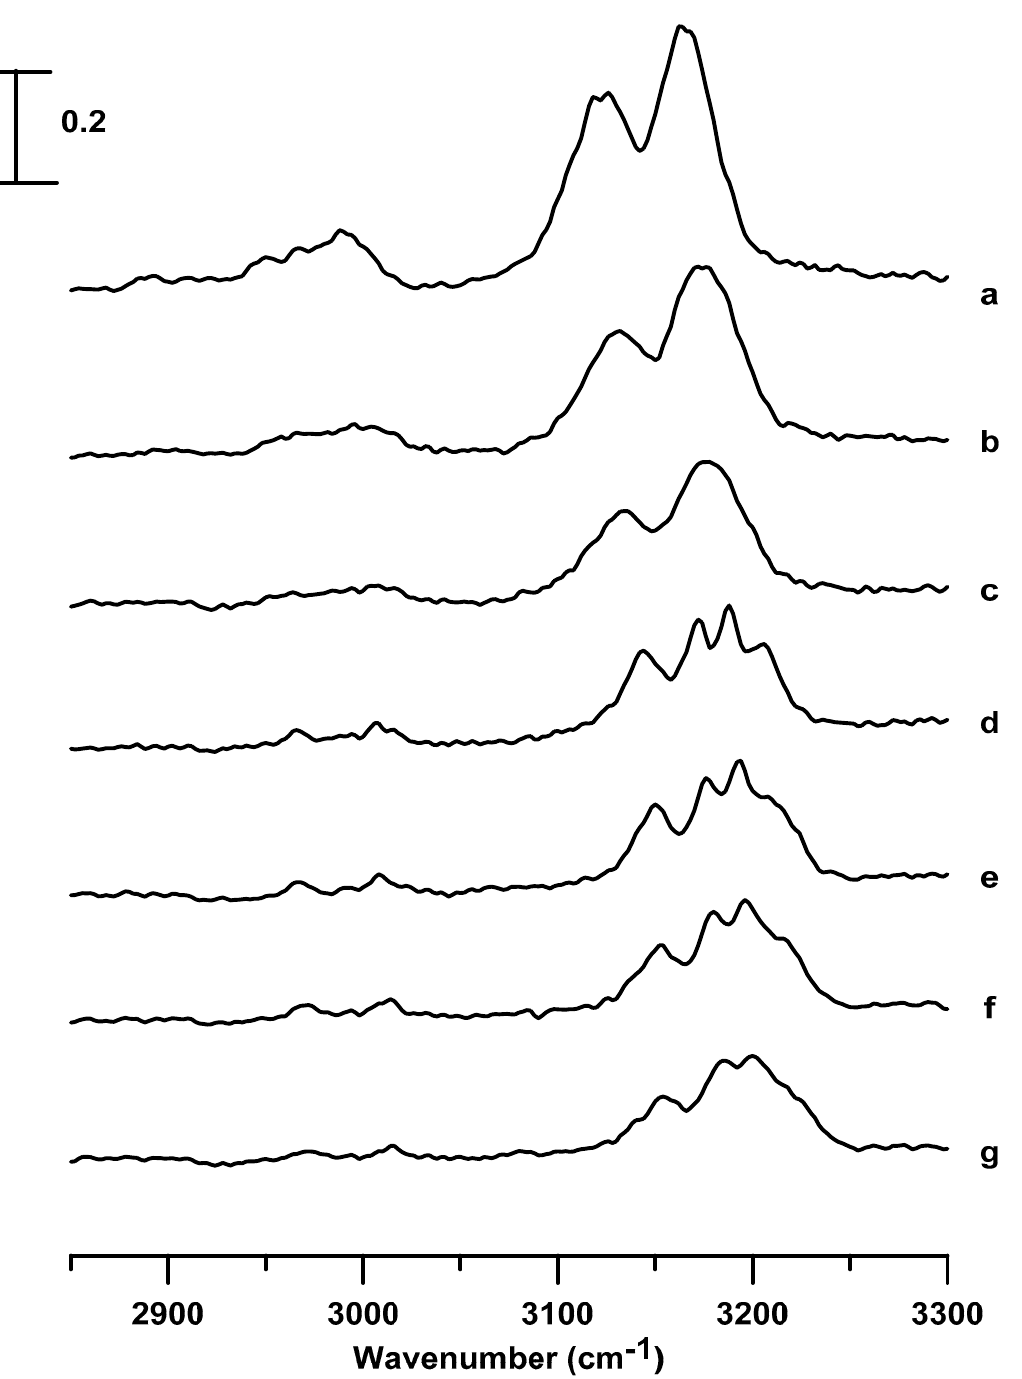
Figure 2. Infrared spectra of the pure [C 2 C 1 Im][BF 4 ] obtained at (a) ambient pressure and at (b) 0.4, (c) 0.7, (d) 1.1, (e) 1.5, (f) 1.8, and (g) 2.5 GPa.